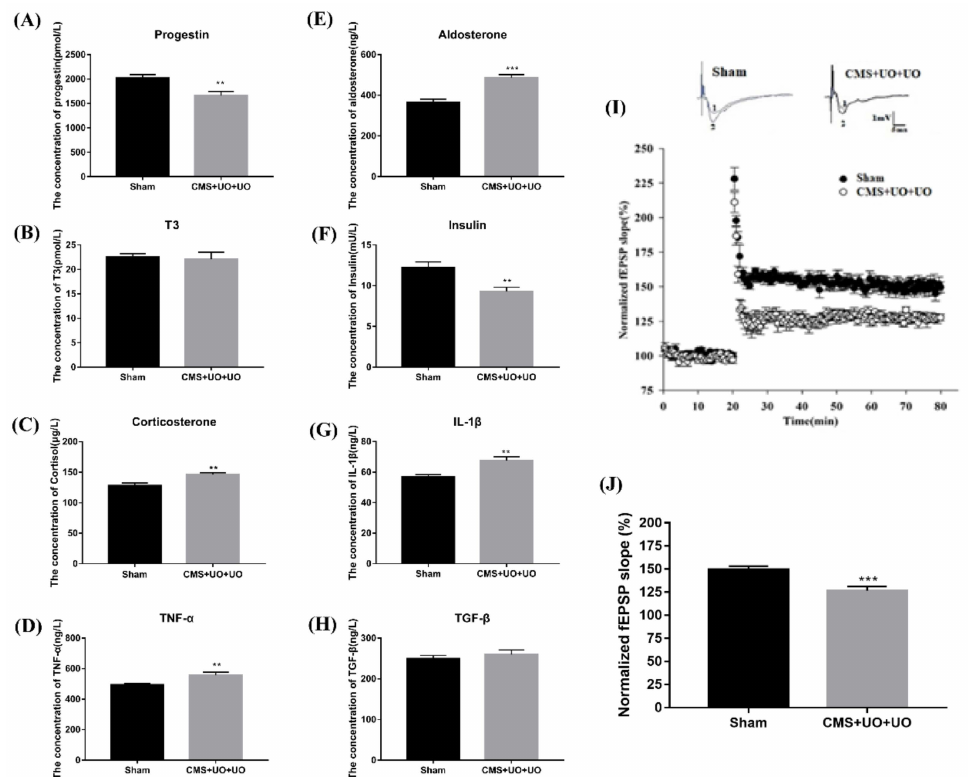
Figure 2. Peri / postmenopausal depression existed in an autonomic nervous dysfunctional and chronic inflammatory status and with synaptic transmission injury. ( A – H ) The expression of hormones and cytokines, including progestin, aldosterone, T3, insulin, S-100, IL-1 β , TNF- α , and TGF- β in the blood, detected by ELISA. Data are presented as means ± SEMs, n = 4~5, ** p < 0.01, *** p < 0.001 versus sham. ( I , J ) Hippocampal synaptic LTP induced by high-frequency stimulation at 100 Hz was recorded in the sham group and in the CMS + UO + UO